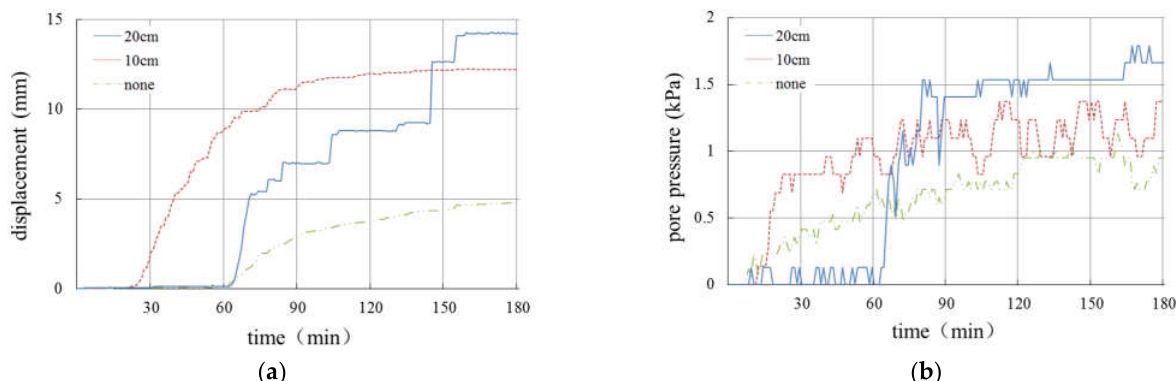
Figure 22. Curves of displacement and pore pressure under rainfall intensity of 30 mm/h. ( a ) Curves of displacement. ( b ) Curves of pore pressure.